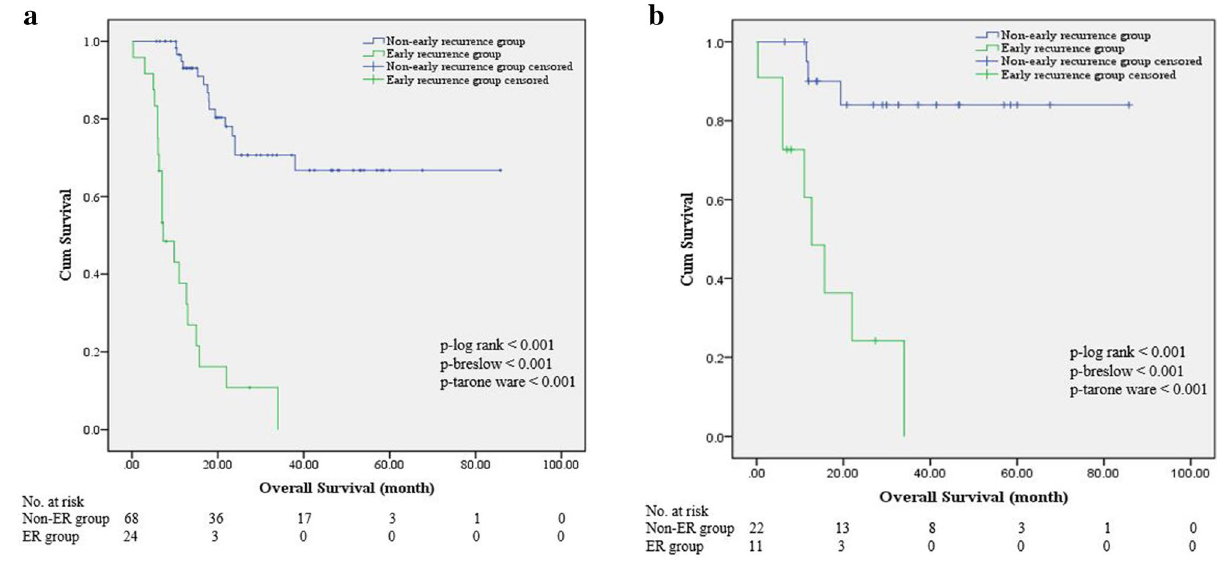
Figure 4. Decision Curve Analysis in the training set ( a ) and test set ( b ), decision curves of the pathological model, preoperative model and combined